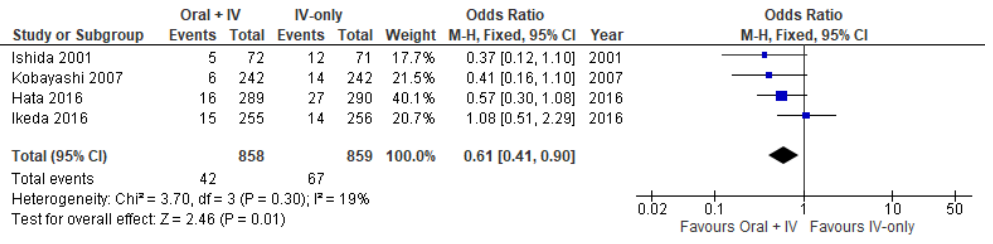
Figure 3. Forest plot of incisional SSIs comparing oral + IV group and IV-only group.